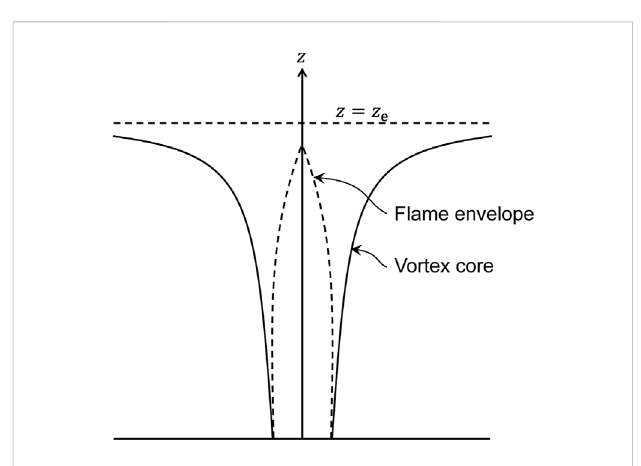
FIGURE 3 Flame and vortex structures proposed by Byram and Martin